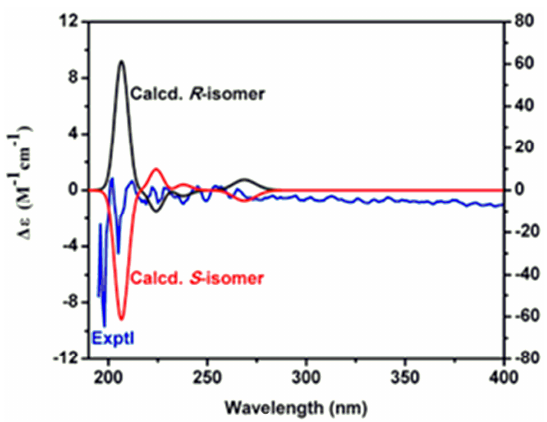
Figure 3. Calculated and experimental electronic circular dichroism (ECD) spectra of compound 1 .